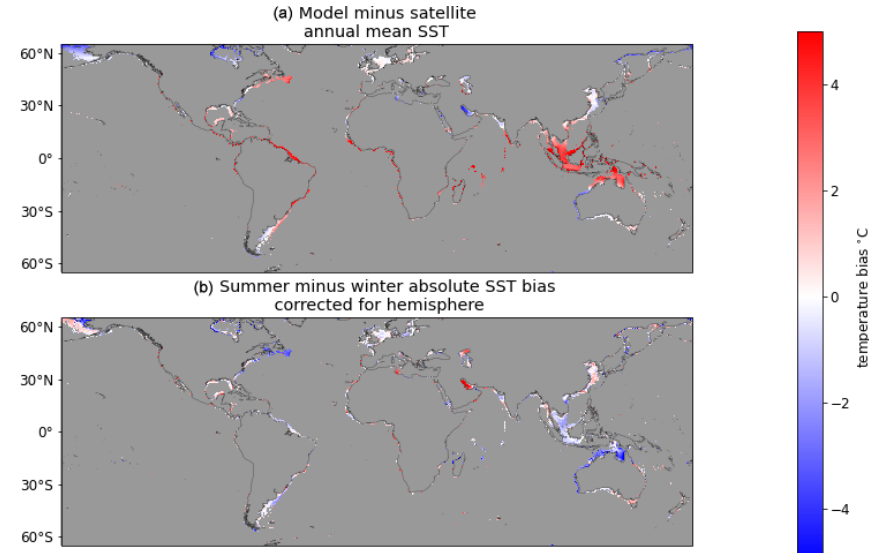
Figure 6. Annual mean SST bias (a) and difference in absolute SST bias between summer and winter (b) . In panel (b) , blue indicates that the summer months (June, July, August in the Northern Hemisphere; December, January, February in the Southern Hemisphere) display a smaller absolute bias than the winter months (December, January, February in the Northern Hemisphere; June, July, August in the Southern Hemisphere).